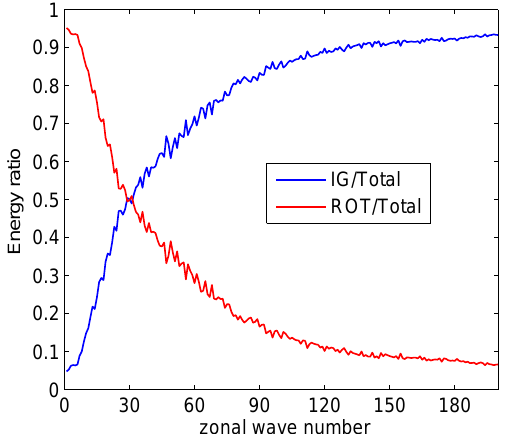
Figure 7. Ratio of balanced (red line) and inertio-gravity (blue line) energy and total energy in each zonal wavenumber. Averaging is performed for 30-year period and for all ( m,n ) .